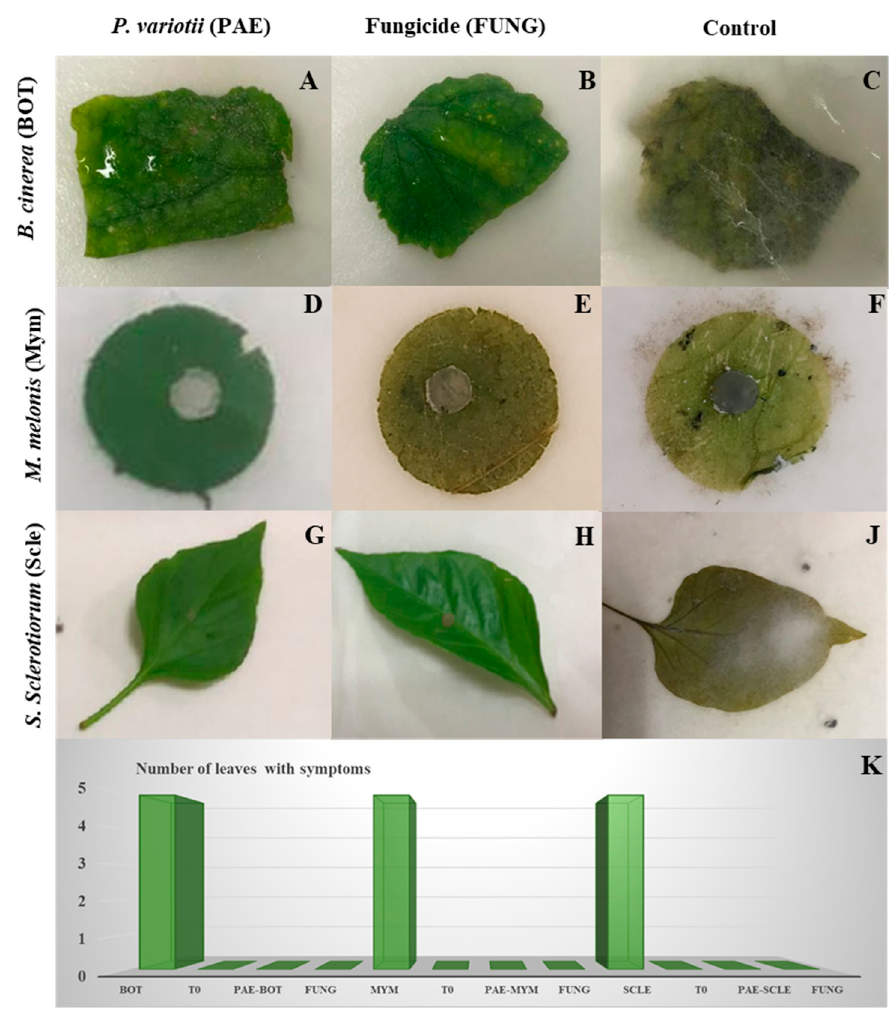
Figure 7. Visual symptoms of B. cinerea ( A – C ), M. melonis ( D – F ), and S. sclerotiorum ( G , H , J ) infection on detached leaves treated with P. variotii ( A , D , G ) or fungicide ( B , E , H ). Control ( C , F , J ): visual symptoms without P. variotii or fungicide. ( K ). Number of leaves with symptoms in each treatment.